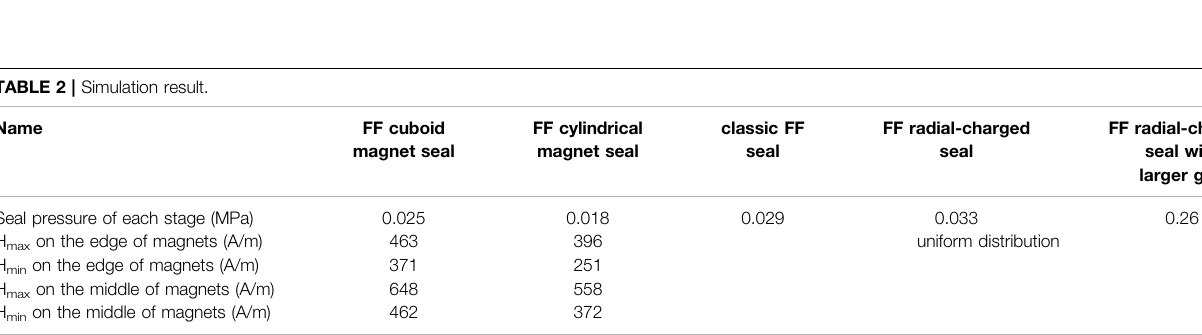
TABLE 2 | Simulation